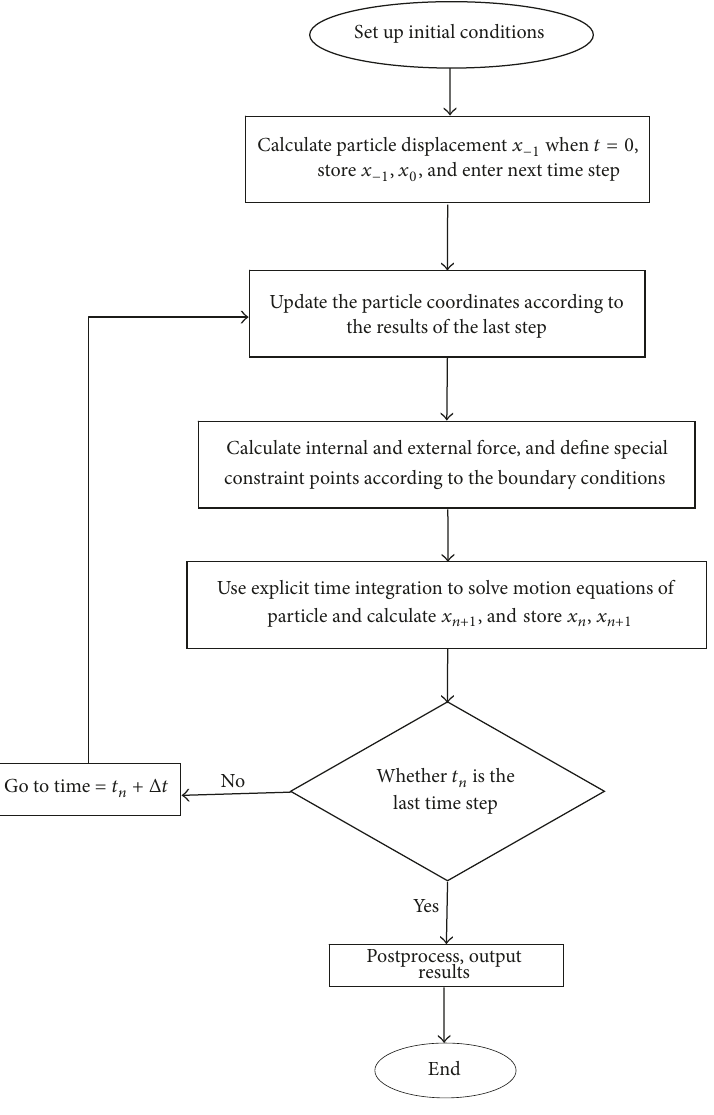
Figure 6: Calculation flow chart using the